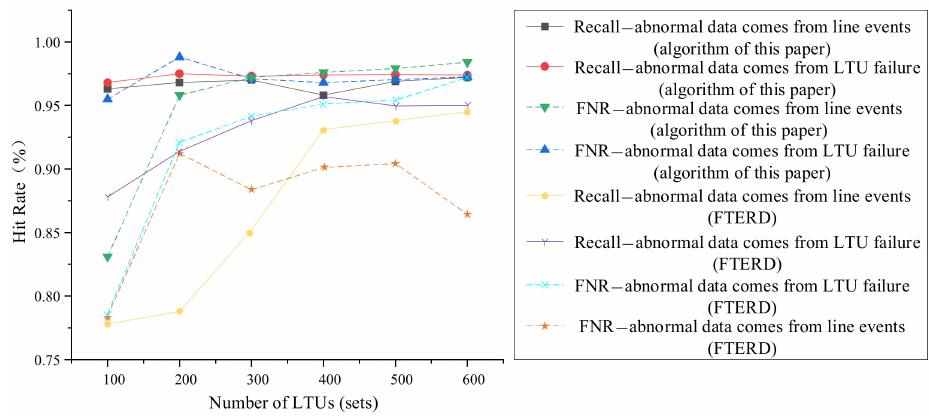
Figure 11. The detection rate of the proposed algorithm and the FTAD algorithm with LTU scales in the distribution Internet of Things.